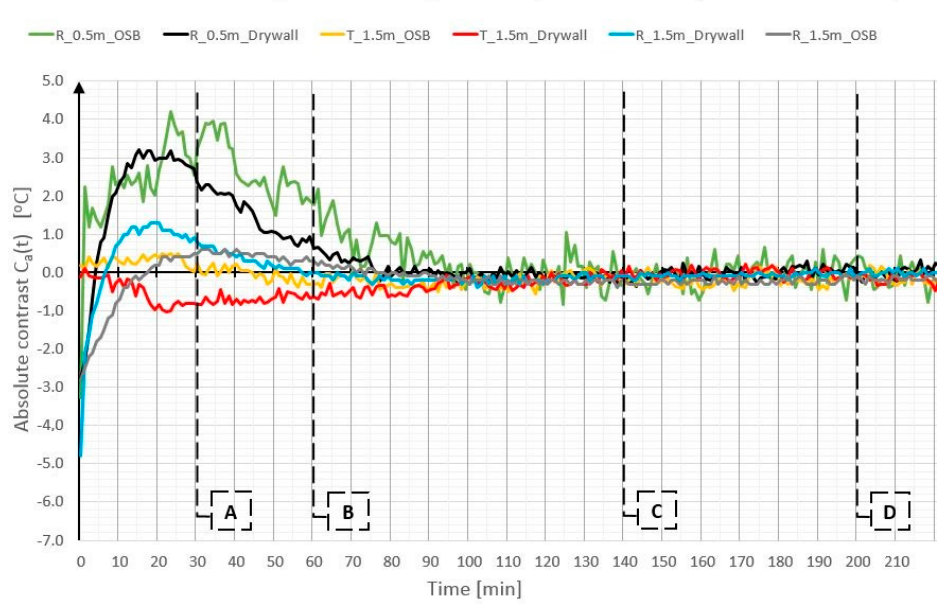
Figure 10. Comparison of absolute contrasts in a reflection mode and in a transmission mode for material inclusion made of Styrofoam.